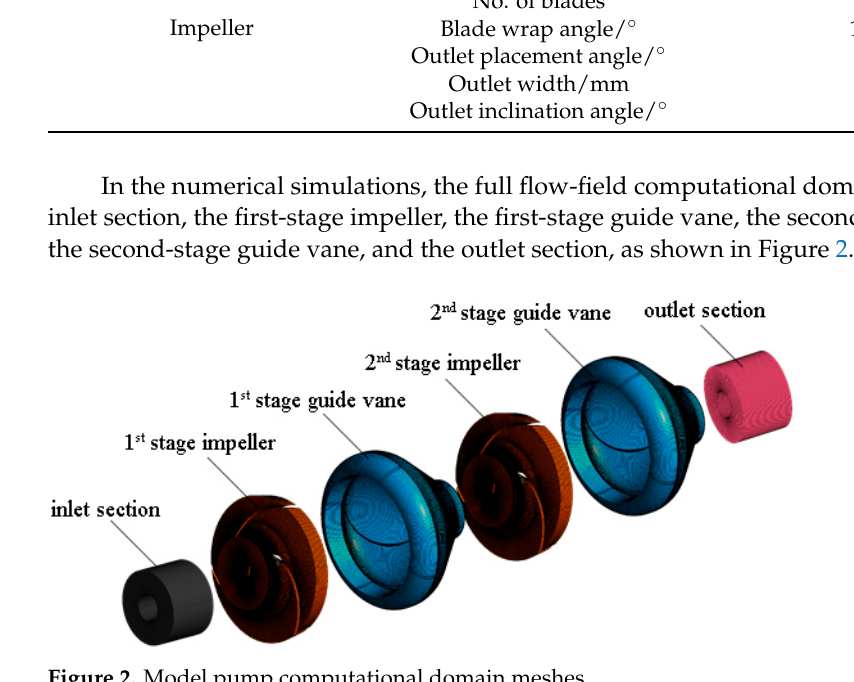
Table 1. Geometric parameters of model pump impeller.